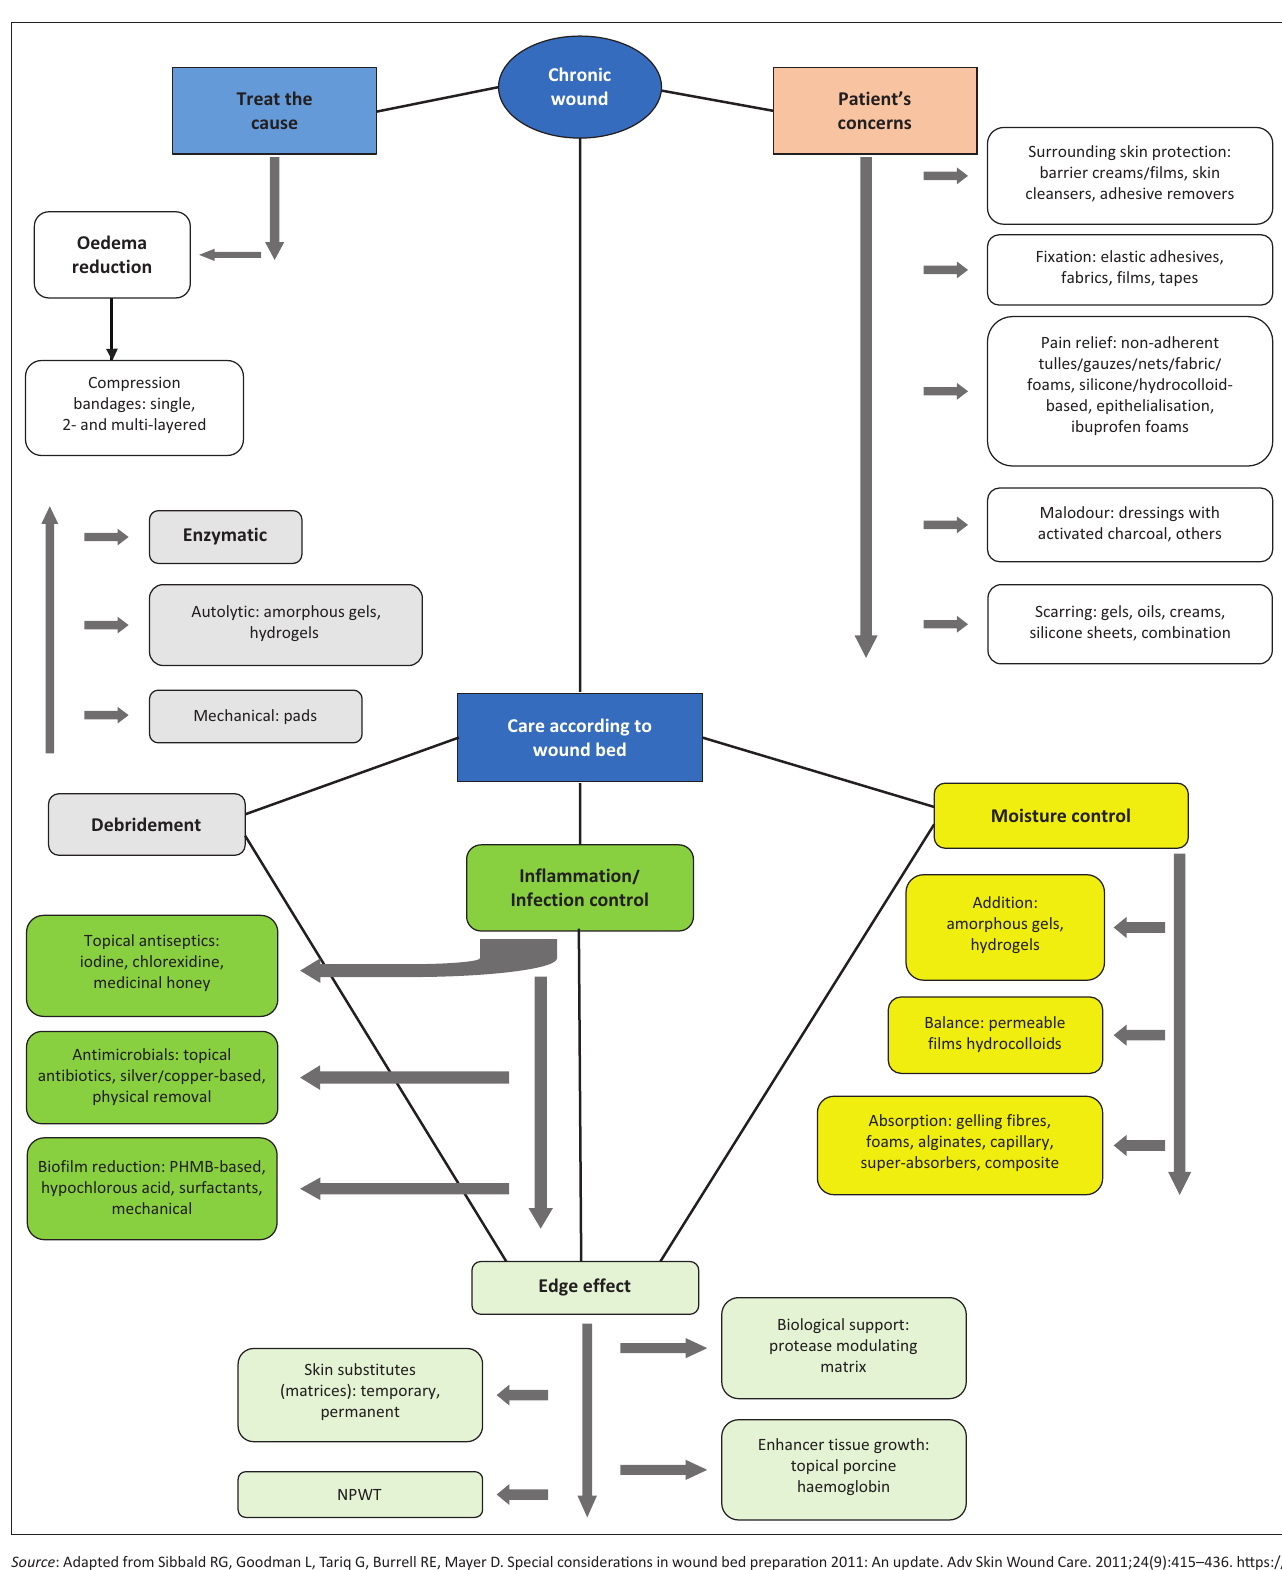
FIGURE 5: Classification of dressings adapted to the wound bed preparation